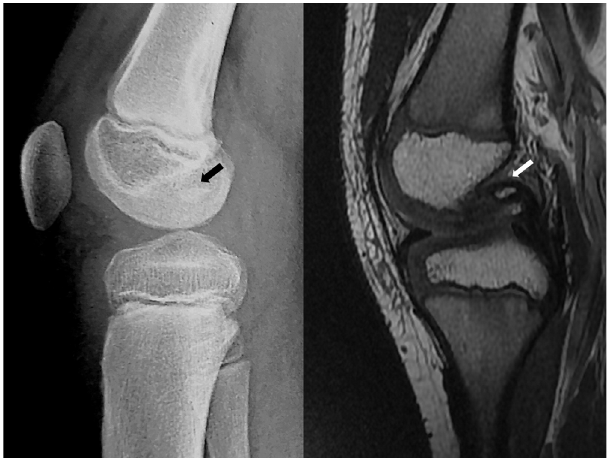
MRI showing ossi fi cation of the cartilaginous PCL avulsion on the femur.